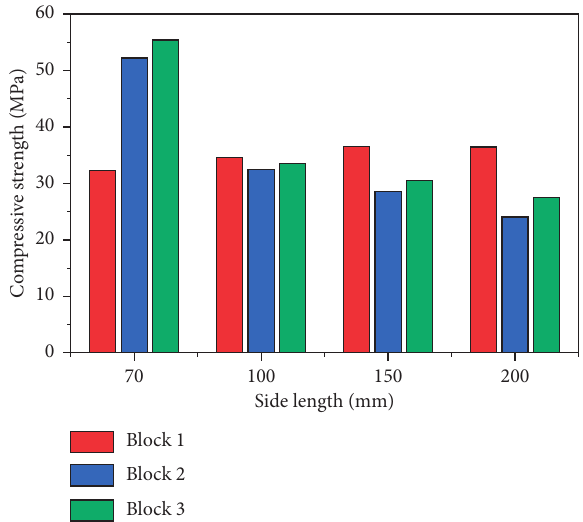
Figure 5: Compressive strength values of cube specimens. Table 6: Mean values and standard deviations of splitting tensile strength